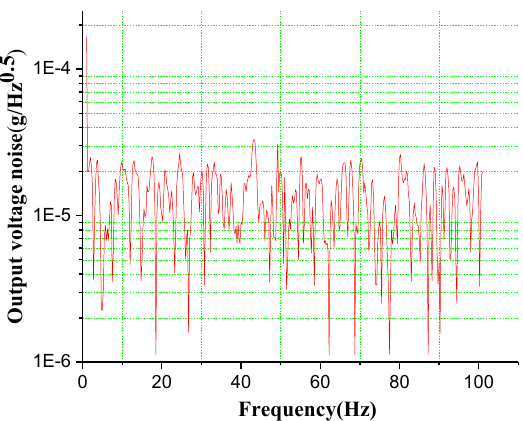
Figure 12. Output voltage noise spectrum of z-axis tunneling magnetoresistive accelerometer.